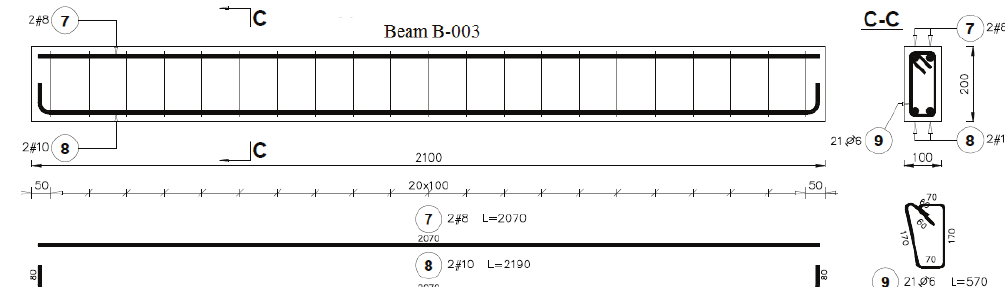
Fig. 3. Beam B-002